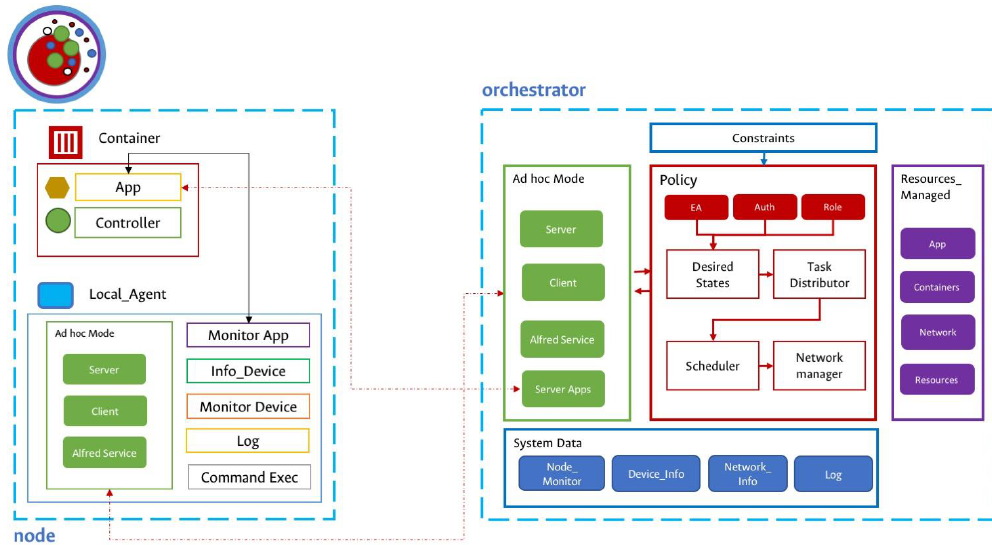
Figure 2. Local Agent-Orchestrator